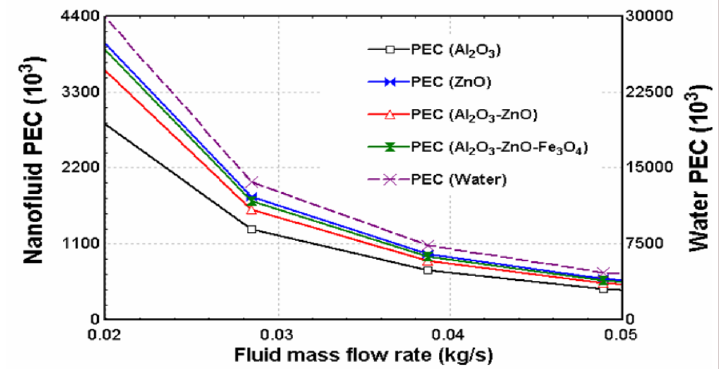
Figure 20. PEC of heat transfer